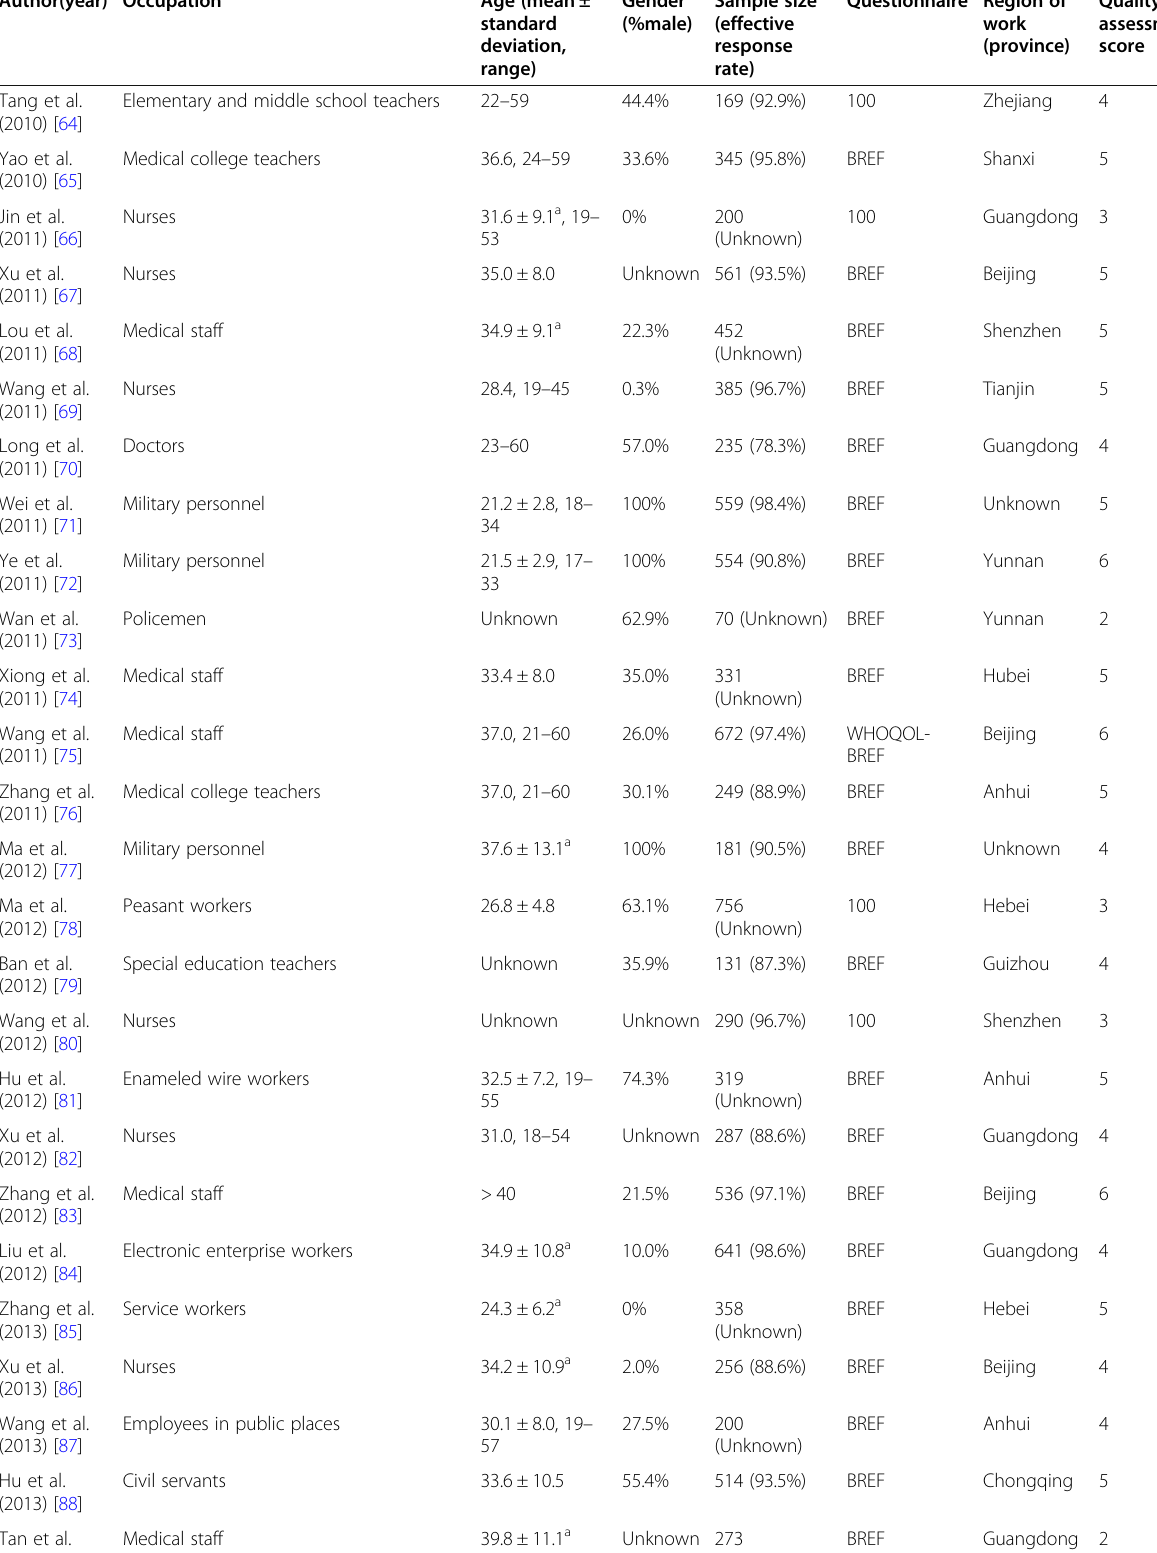
Table 2 Descriptive characteristics and quality assessment of the included publications